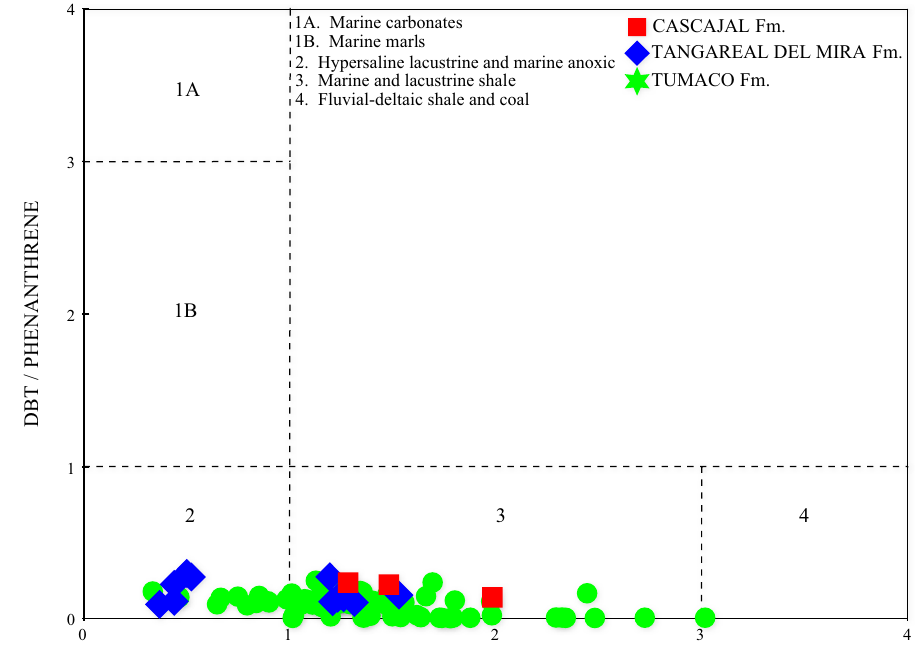
Fig. 15 Geochemical correla- tion between DBT/P versus Pr/Ph in the organic extracts from rock in Tumaco-1-ST-P, Tumaco basin,